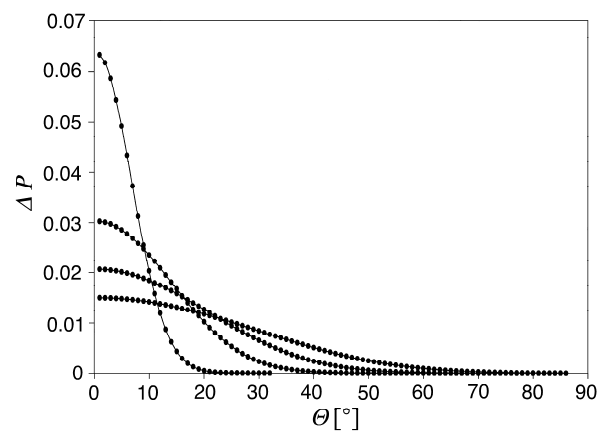
Fig. 5. The probability distribution Δ P as a function of the corresponding zenith angle θ in air. The curves represent from top to bottom in the left part of the graph the wind speeds 0, 2, 5 and 10 m s -1 .